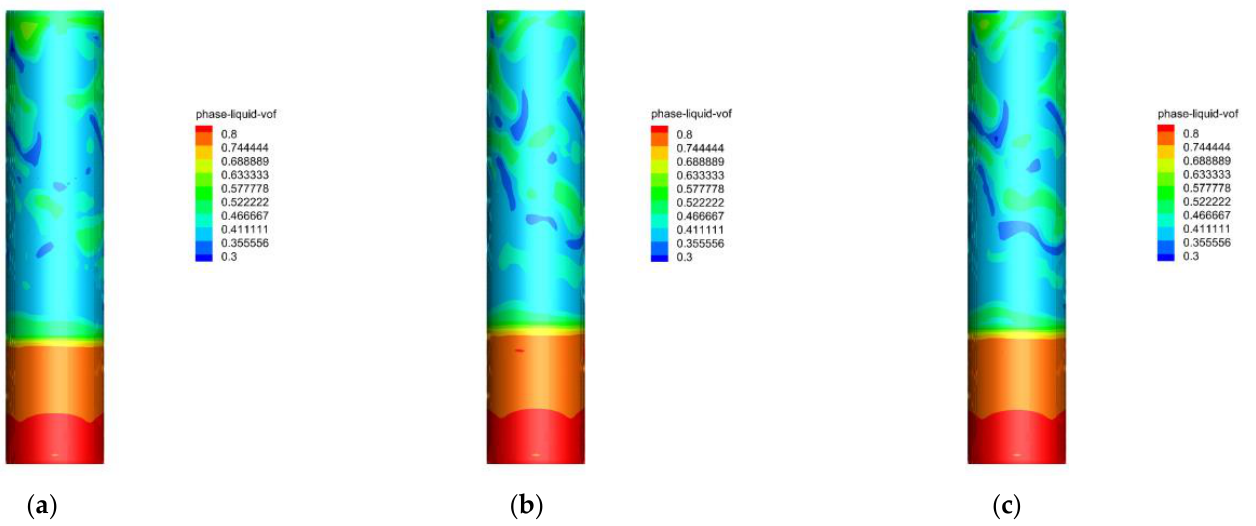
Figure 4. Distribution of the gas-liquid-foam during the separation process at 30 s, where the grid numbers are 65,500 ( a ), 126,000 ( b ), and 183,700 ( c ), respectively.